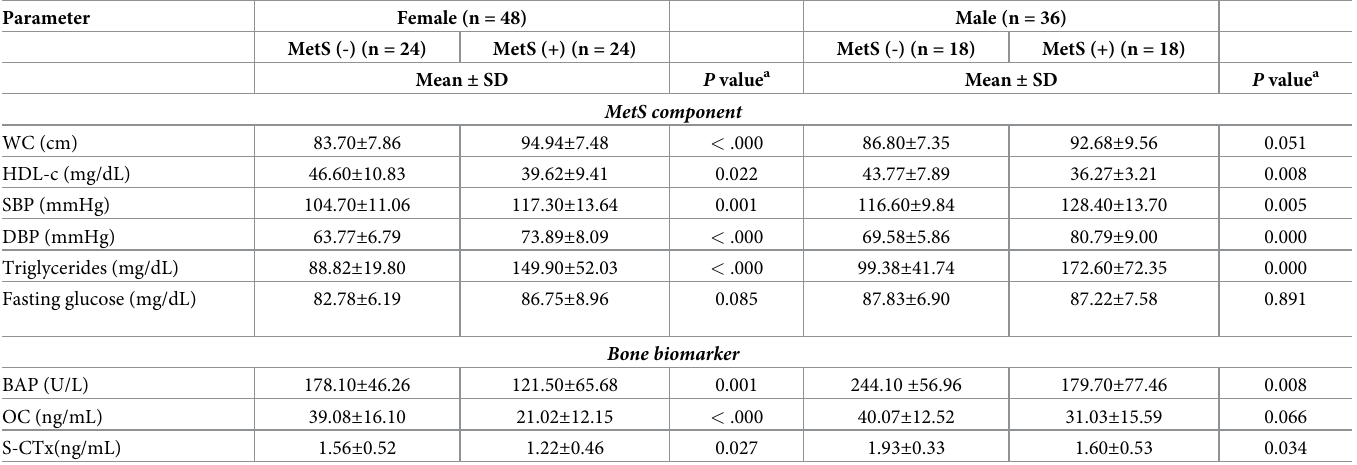
Table 2. Comparison of metabolic syndrome components and bone biomarkers between adolescents with and without MetS according to sex. Parameter